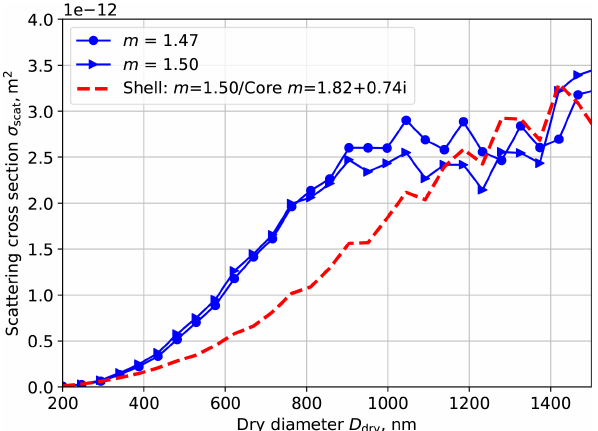
Figure 7. Relation between scattering cross section, refractive in- dex and diameter for a wavelength of 550nm. Blue lines are for non- absorbing particles, and symbols indicate the refractive index. The red line is for absorbing particles containing a BC core of 0 . 2 D dry (constant BC volume fraction across the size